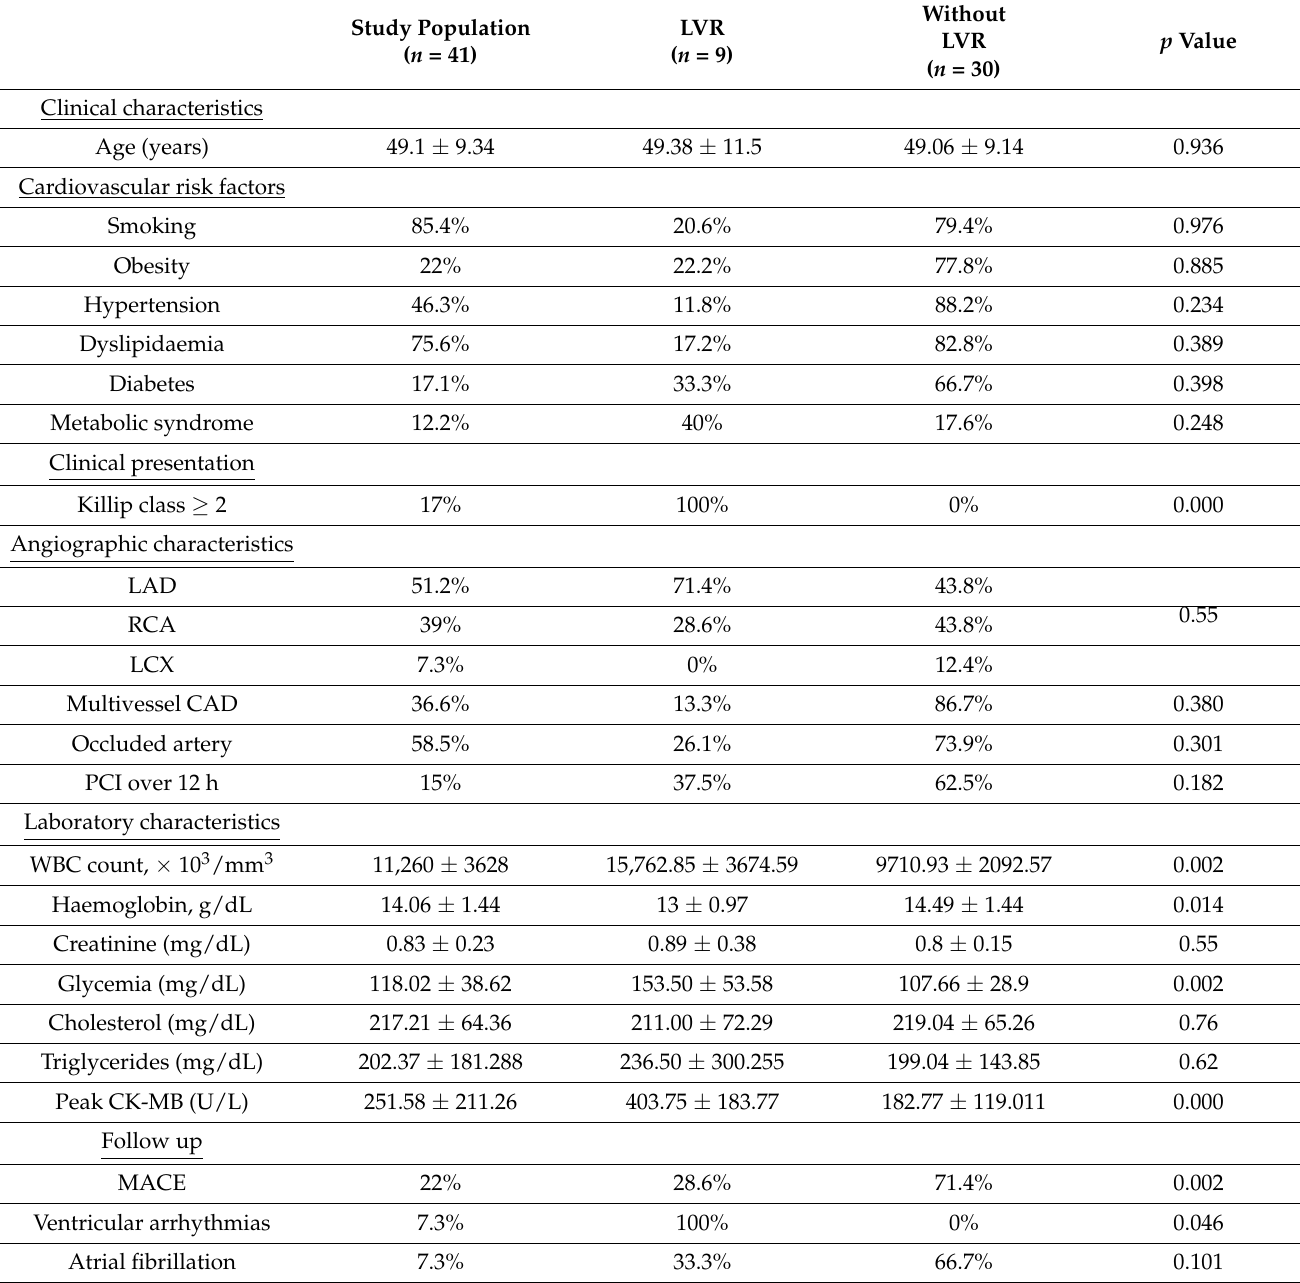
Table 1. Baseline characteristics of the entire study population and divided into two subgroups according to the occurrence of LVR at follow